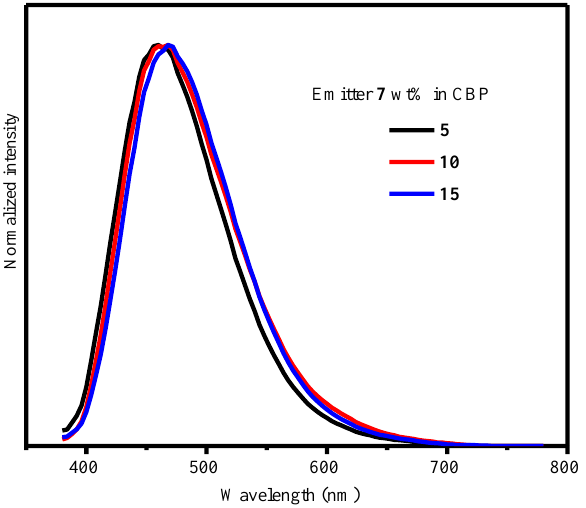
Figure 3. Emission spectra of OLEDs using emitter 7 in CBP host.